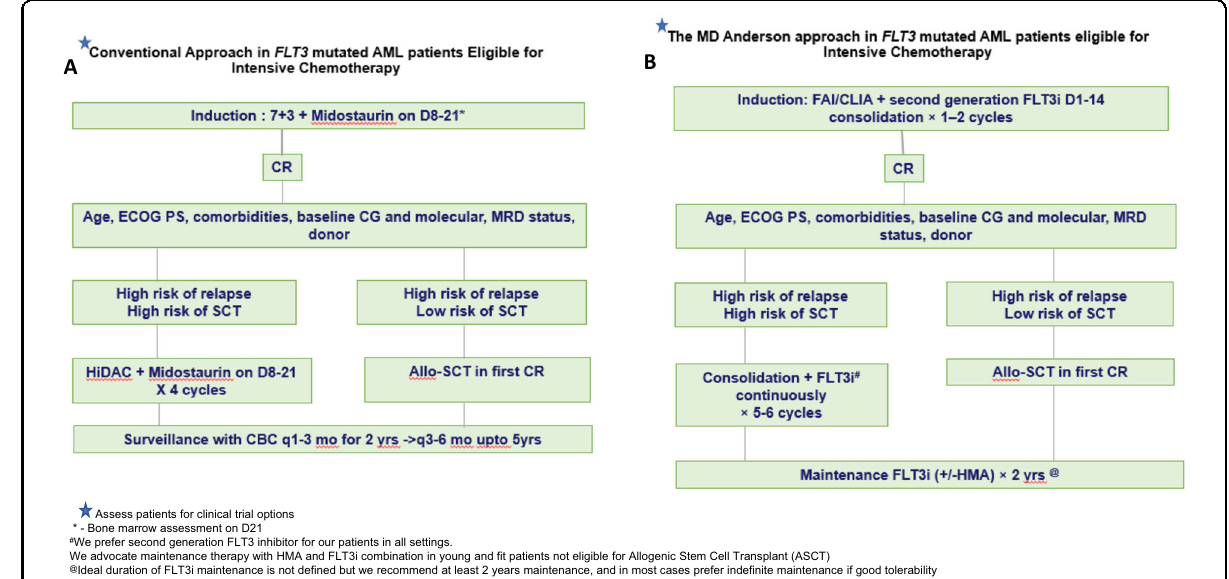
Fig. 1 Treatment algorithm of FLT3 -ITD-mutated AML in patients eligible for intensive chemotherapy. A Conventional approach. B MD Anderson Cancer Center Approach. 7 + 3 — 7 days of cytarabine and 3 days of daunorubicin. F fl udarabine, I idarubicin, CL cladribine, A cytarabine 1.5 – 2 g/m 2 , HMA hypomethylating agent, CR complete remission, ECOG PS Eastern Cooperative Oncology Group Performance Status,